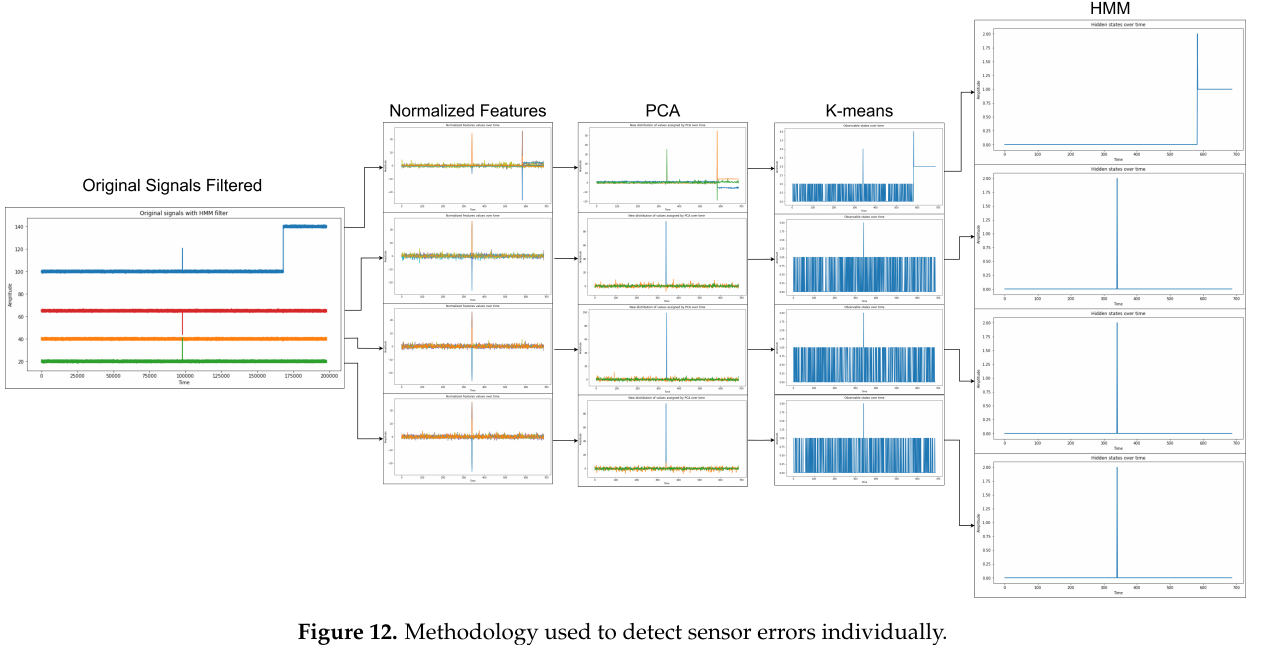
Figure 12. Methodology used to detect sensor errors